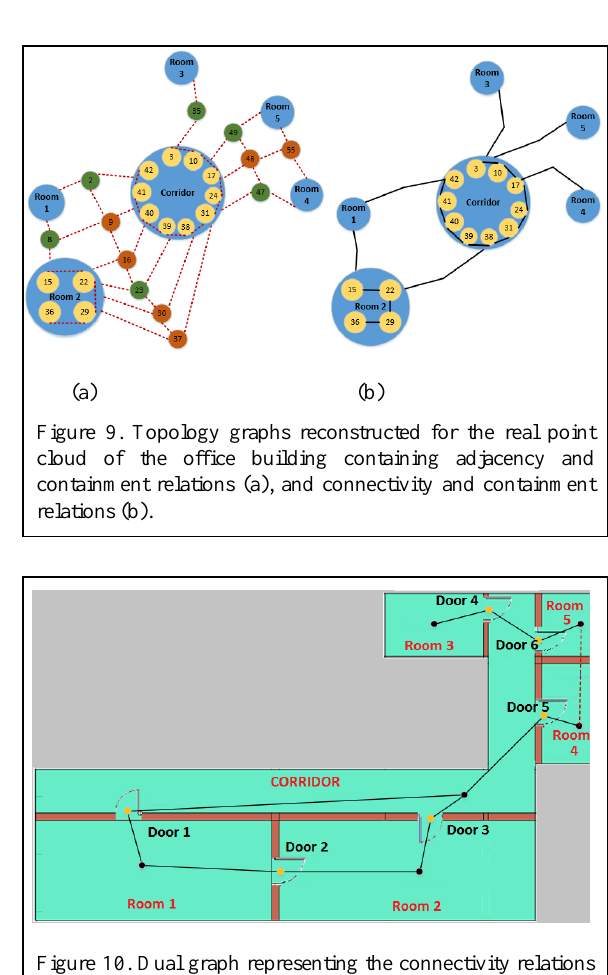
Figure 10. Dual graph representing the connectivity relations (black solid lines) and adjacency relations (red dashed lines) reconstructed from the real point cloud of the office